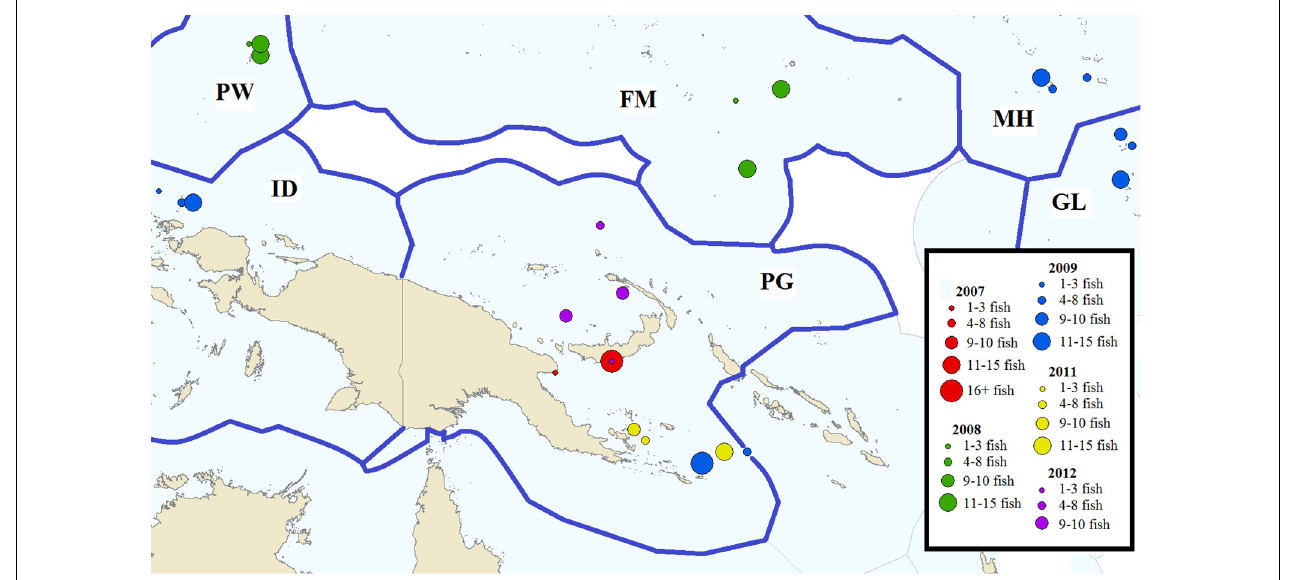
FIGURE 1 | Map of sample site locations. Size of circle represents the number of fish